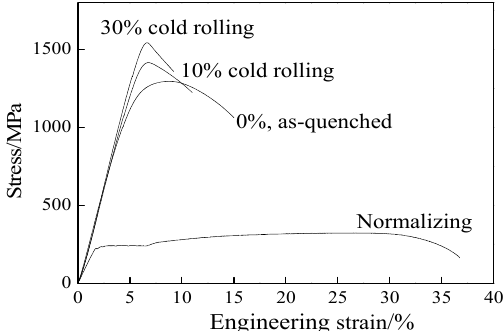
Figure 6. Tensile curves of the experimental steels at different states (quenched and cold rolled states). The yield strength, tensile strength, hardness, elongation, and impact toughness of the experimental steel after quenching and cold rolling are shown in Figure 7. After quenching, the strength and hardness markedly increased, while the elongation decreased compared with the normalized specimen. The hardness and tensile strength of the initial martensite were 440 HV and 1302 MPa, respectively.